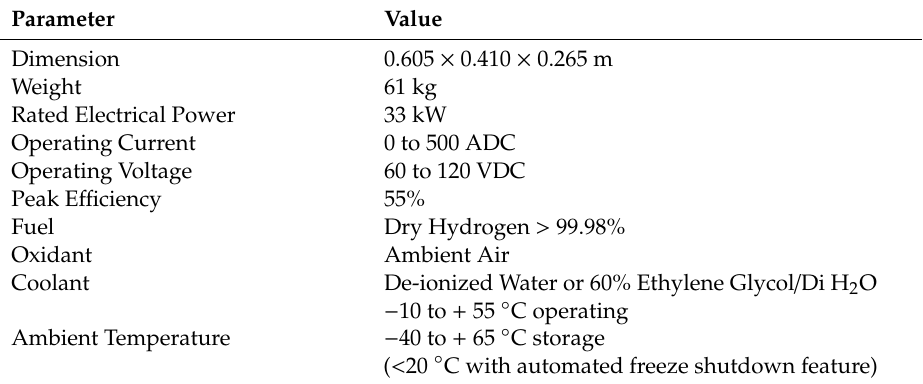
Table 3. Fuel cell specification used in calculations